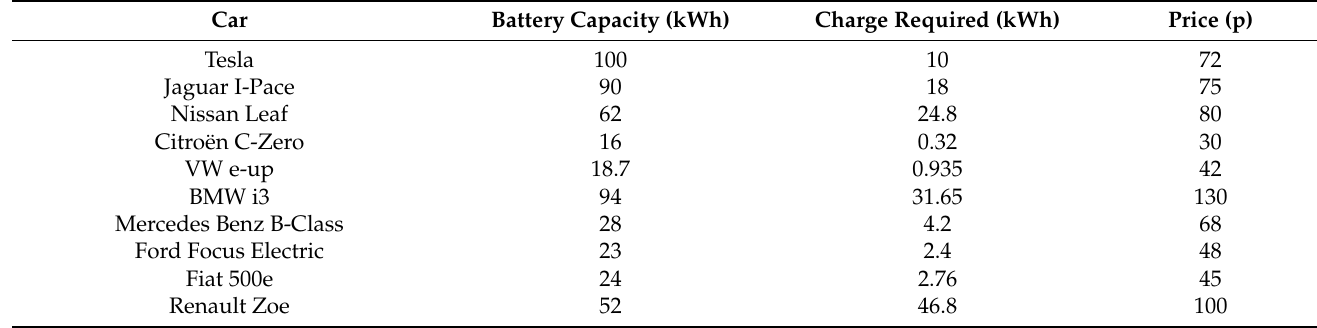
Table 10. Car charge level